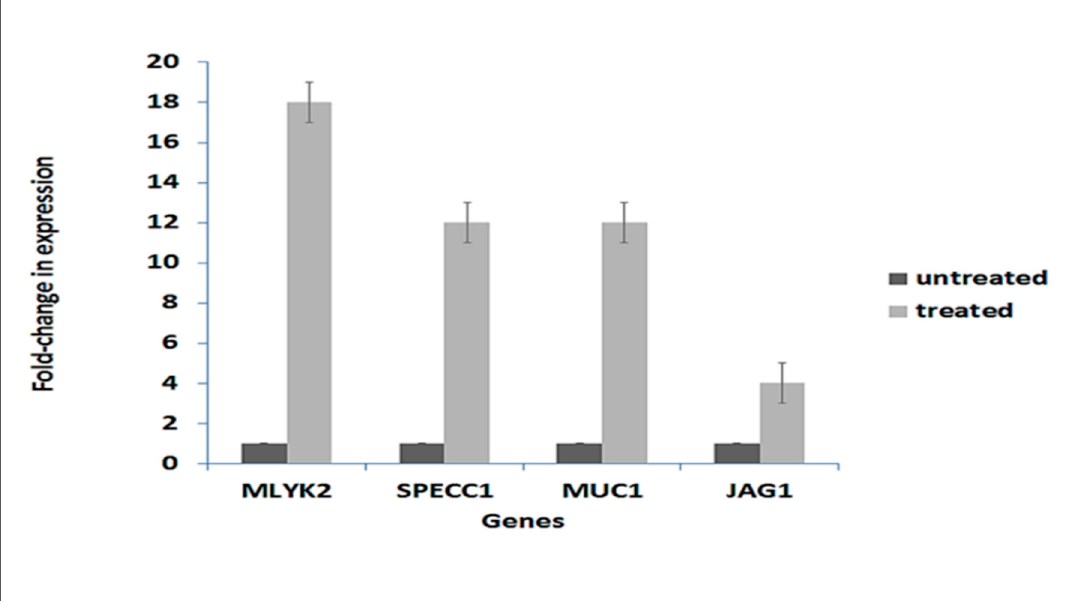
Figure 9. qPCR validation of expression of selected genes from transcriptome analysis data. One gene from each gene group in Figure 8 was selected. Their expression was determined by qPCR according to the 2 −ΔΔ C t method using RPL13A as an internal control [14]. Expression of each gene was normalized to the expression level of the gene in untreated cells, which was assigned a value of 1. Data represent the average of three independent experiments ± SD. Each independent experiment comprised three biological replicates. Untreated, control cells; Treated, 4.5 h after exposure of cells to A. graveolens extract.